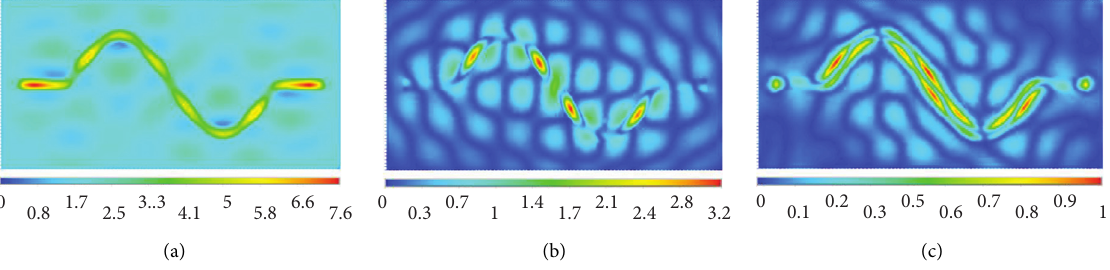
� 400m/s, f � 1.5Hz, H � 100m, and NR � 2). Top view displacement cloud view (a) u s